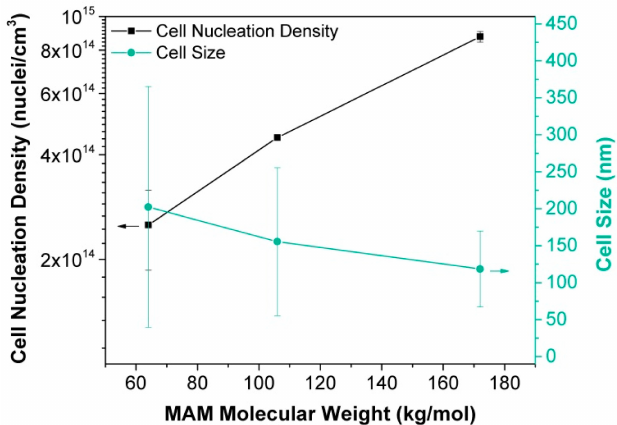
Figure 7. SEM micrographs of the nanocellular polymers based on PMMA/MAM blends with low ( a ), medium ( b ) and high ( c ) MAM molecular weight.